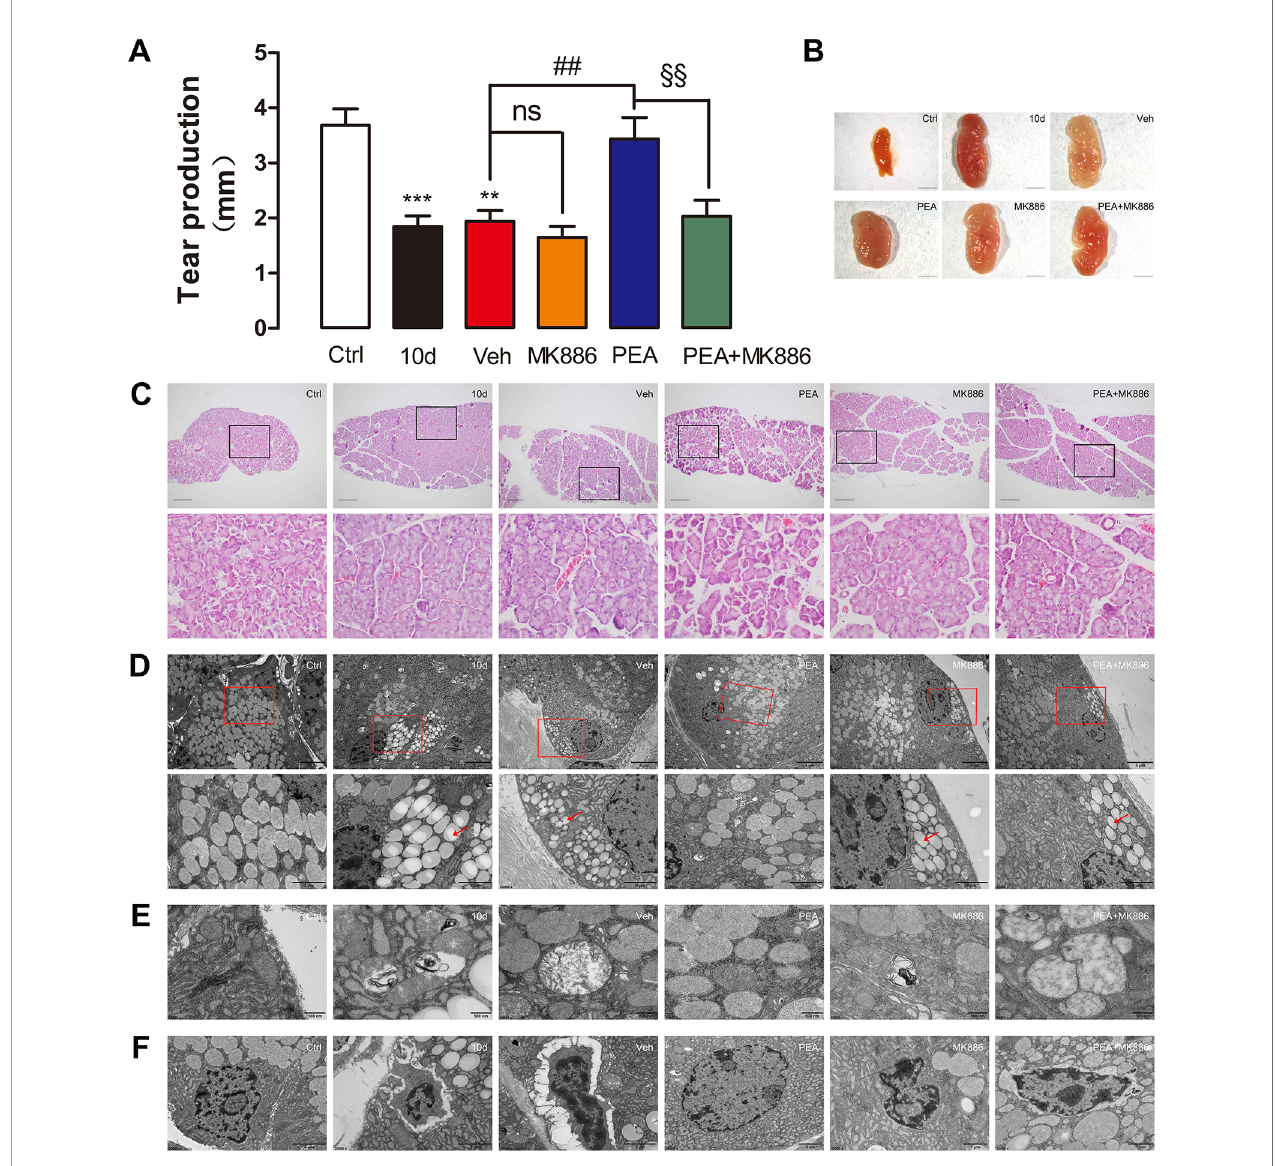
FIGURE 10 | Pretreatment with PPAR- a antagonist MK886 blocked the effects of PEA on SD-induced mice LG. MK886 blocked tear production (A) , normalization of LG (B) and acinar cell size (C) rescued by PEA in SD-induced mice. Transmission electron microscope (TEM) observation indicated that the effects of PEA against lipid accumulation, mitochondrial swelling, and nuclear pyknosis were completely abolished by pretreatment of MK886 (D – F) . **, P < 0.01, ***, P < 0.001 vs. control group; ns, not signi fi cant, ## , P < 0.01 vs. vehicle group; §§ , P < 0.01 vs. PEA group; one-way ANOVA followed by Dunette ’ s post hoc , n =